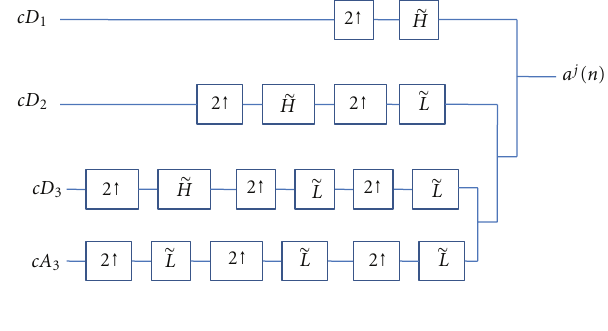
Figure 6: Multiresolution